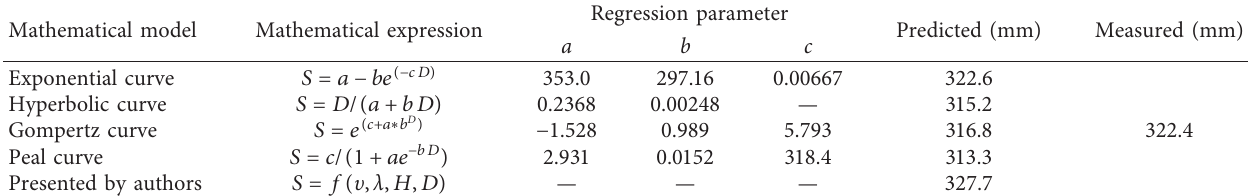
Table 7: Regressive models of PCS and its parameters.